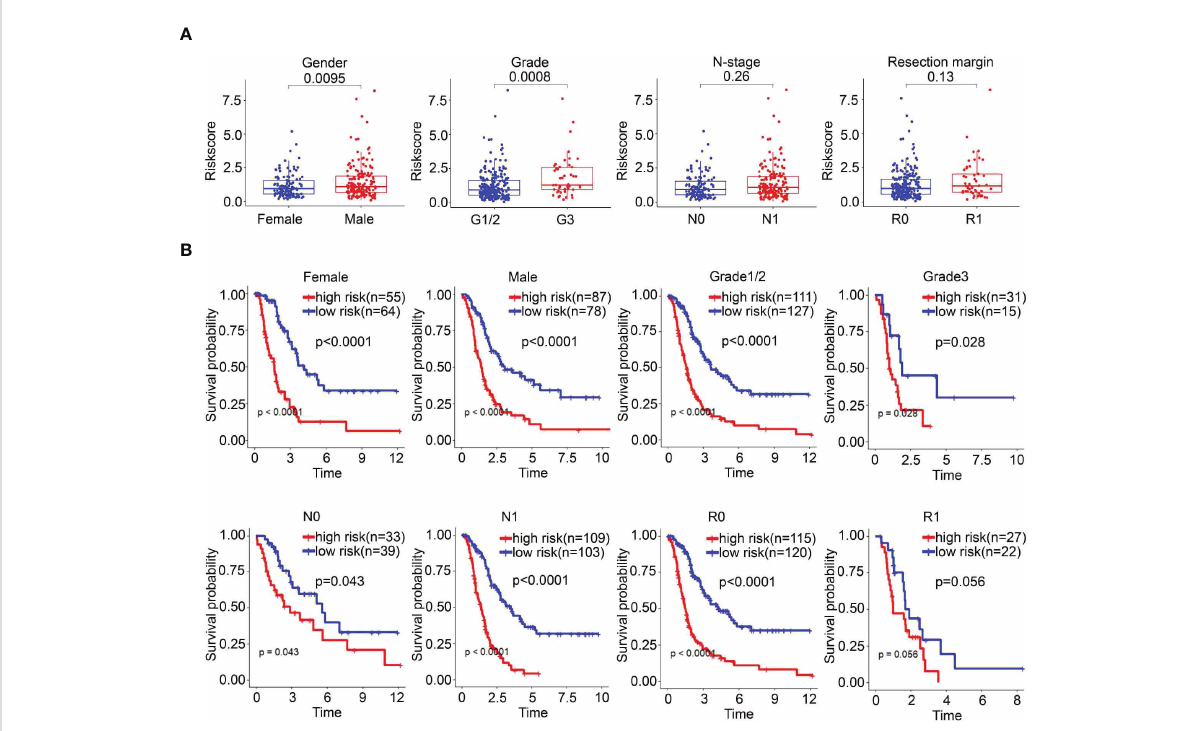
FIGURE 6 The survival outcomes of PDAC cancer patients in different risk groups. (A) Correlation between risk score and clinicopathological parameters. (B) Strati fi ed analysis of the E-MTAB-6134 cohort. The survival outcomes of PDAC cancer patients with different risk scores in subgroups based on clinicopathological